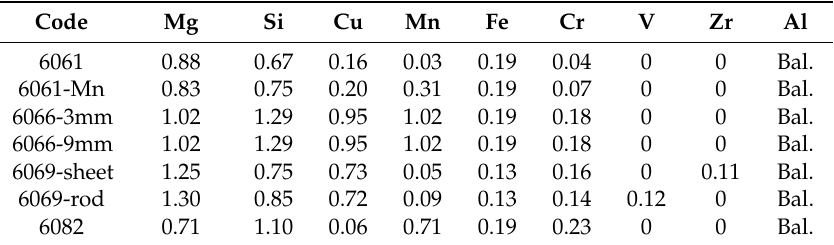
Table 1. Compositions of Al–Mg–Si alloys used in this research (Unit: wt. %). Code Mg